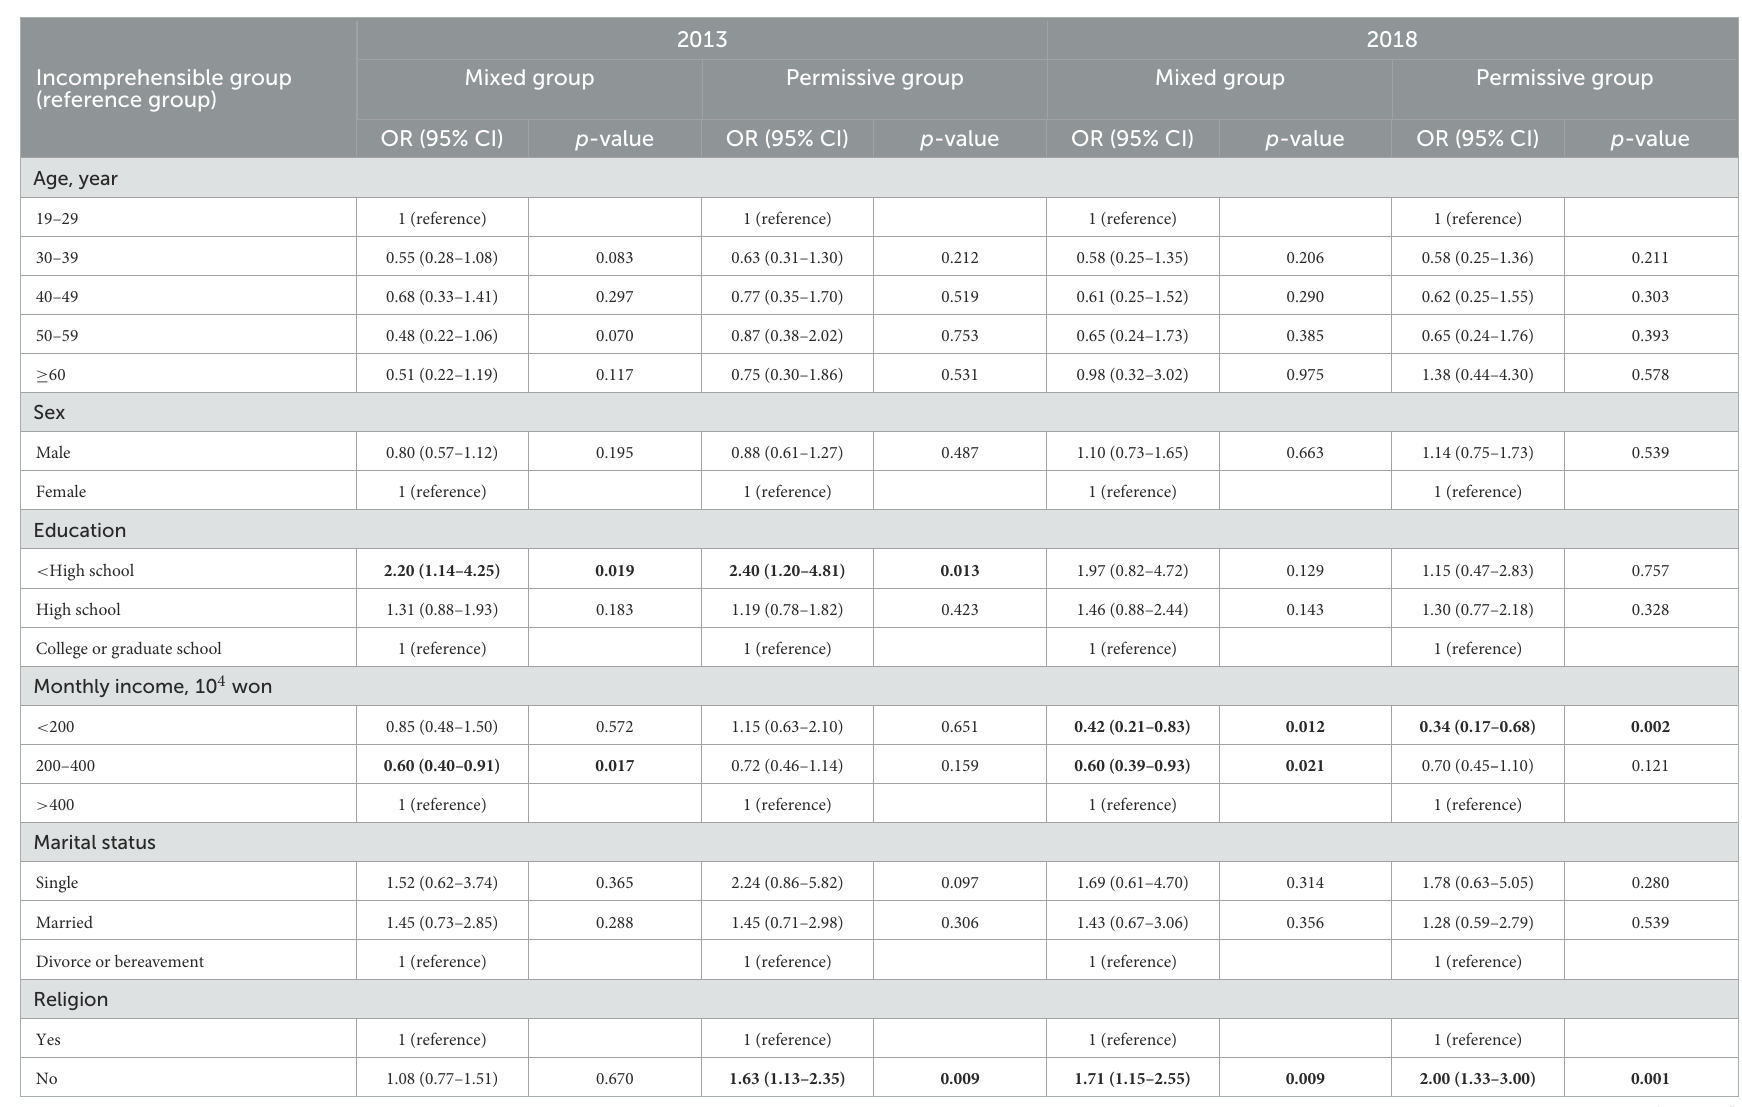
TABLE 5 Multinomial logistic regression assessing the three classes in each survey